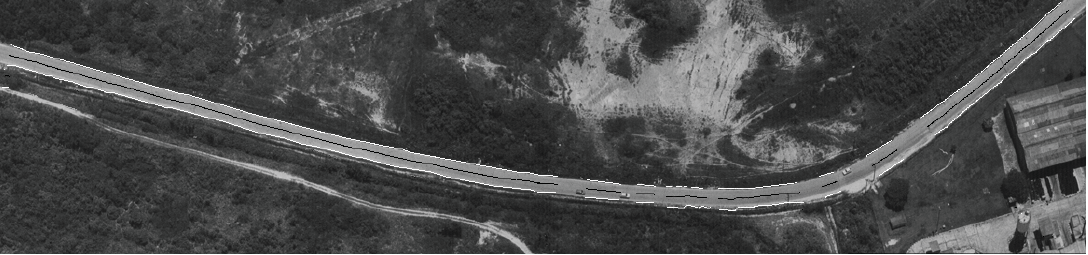
Fig. 11 – Results obtained with the high-resolution image